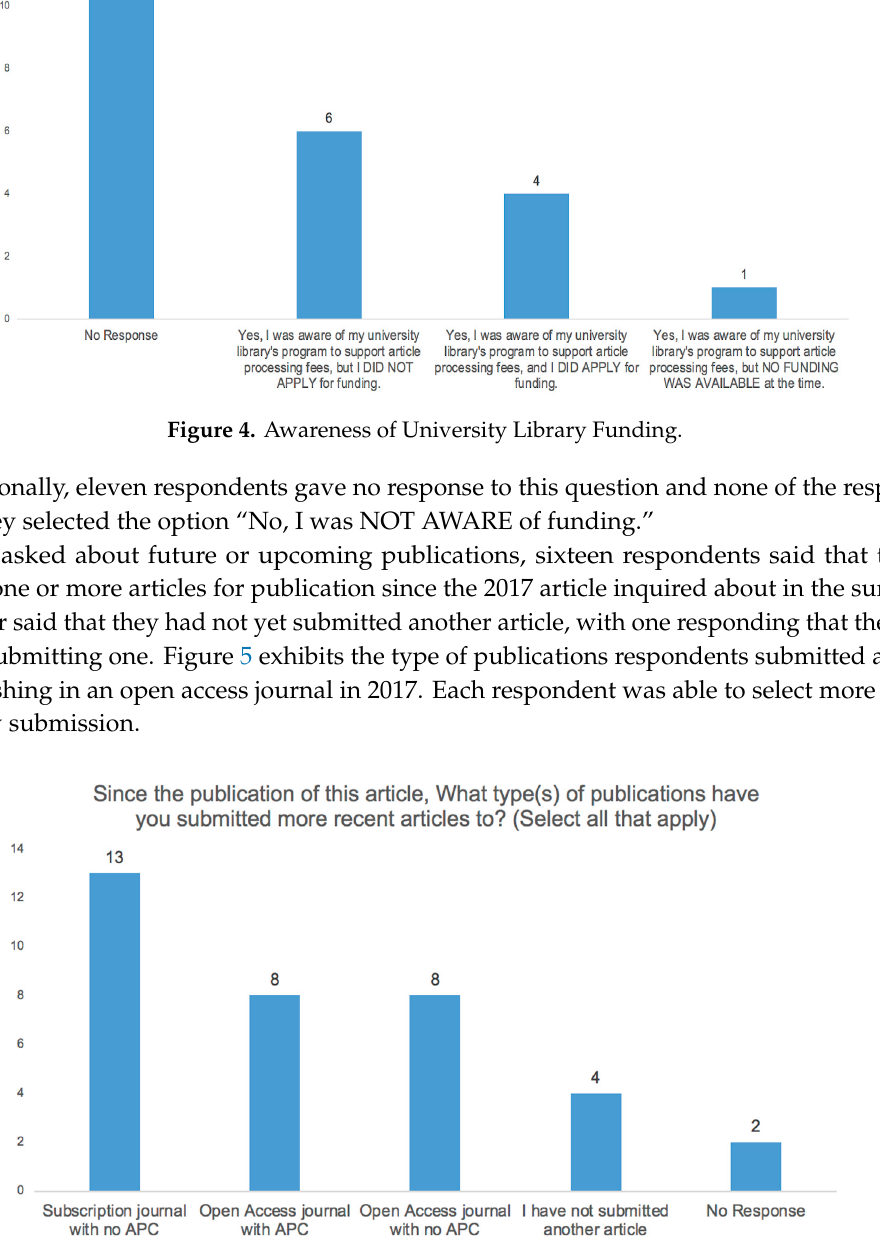
Figure 5. Venue of More Recent Articles Submitted for Publications.